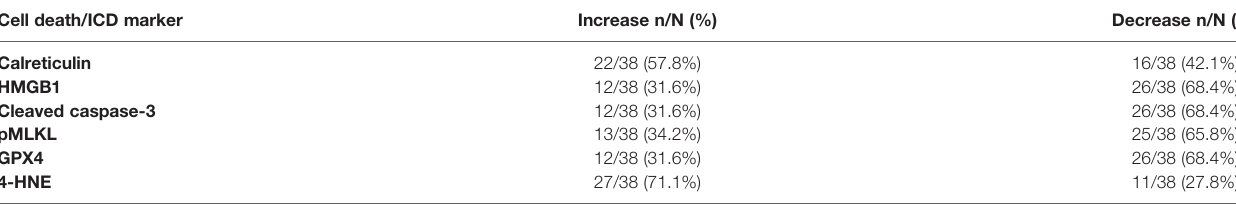
The number and percentage of patients showing an increase/decrease in the cell death/DAMP markers after the treatment (hysterectomy sample levels compared to initial biopsy sample levels)areshownforcalreticulin,HMGB1,cleavedcaspase-3,pMLKL,GPX4,and4-HNE.n=numberofpatientswithanincreaseordecreaseofcelldeath/ICDmarkerinhysterectomy;N = total number of patients; pMLKL = phosphorylated mixed lineage kinase domain like pseudokinase; 4-HNE =